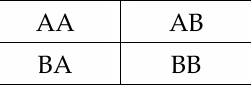
Figure 1. Scheme for selecting the image scan areas.